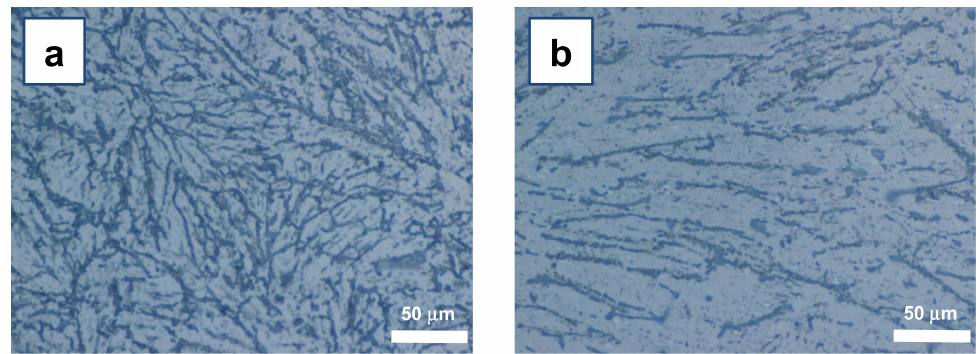
Figure 3. Topology of PLGA nanofibers developed using the M200 solution type, at room temperature upon chloroform evaporation and menthol sublimation, carried out ( a ) in open air, and ( b ) under a closed Petri dish. The imaged area is about 0.85 mm 2